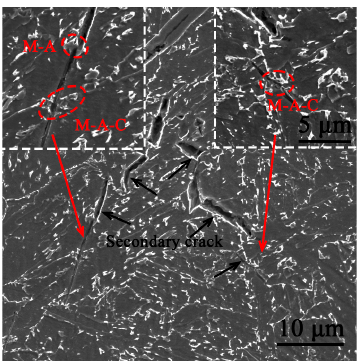
Figure 12. Secondary cracks were observed on the profile of the impact samples induced by broken M-A constituents. Table 4. The deviation between the calculated value and experimental